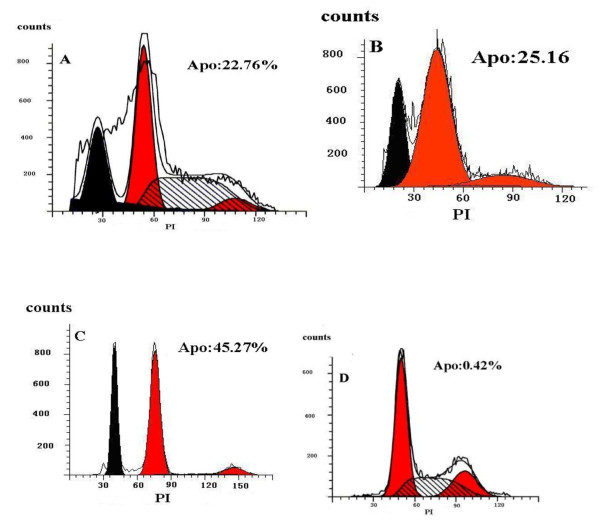
Flow cytometry showed that apoptosis of Hela/TK cells was induced by the different methods. A. gene treatment group; B. 60Co radiotherapy group; C. Combined treatment; D. control group, and the cells of apoptotic index (AI) were 22.76 ± 3.51%, 25.15 ± 3.17%, 45.27 ± 5.15, 0.42 ± 0.13% respectively.